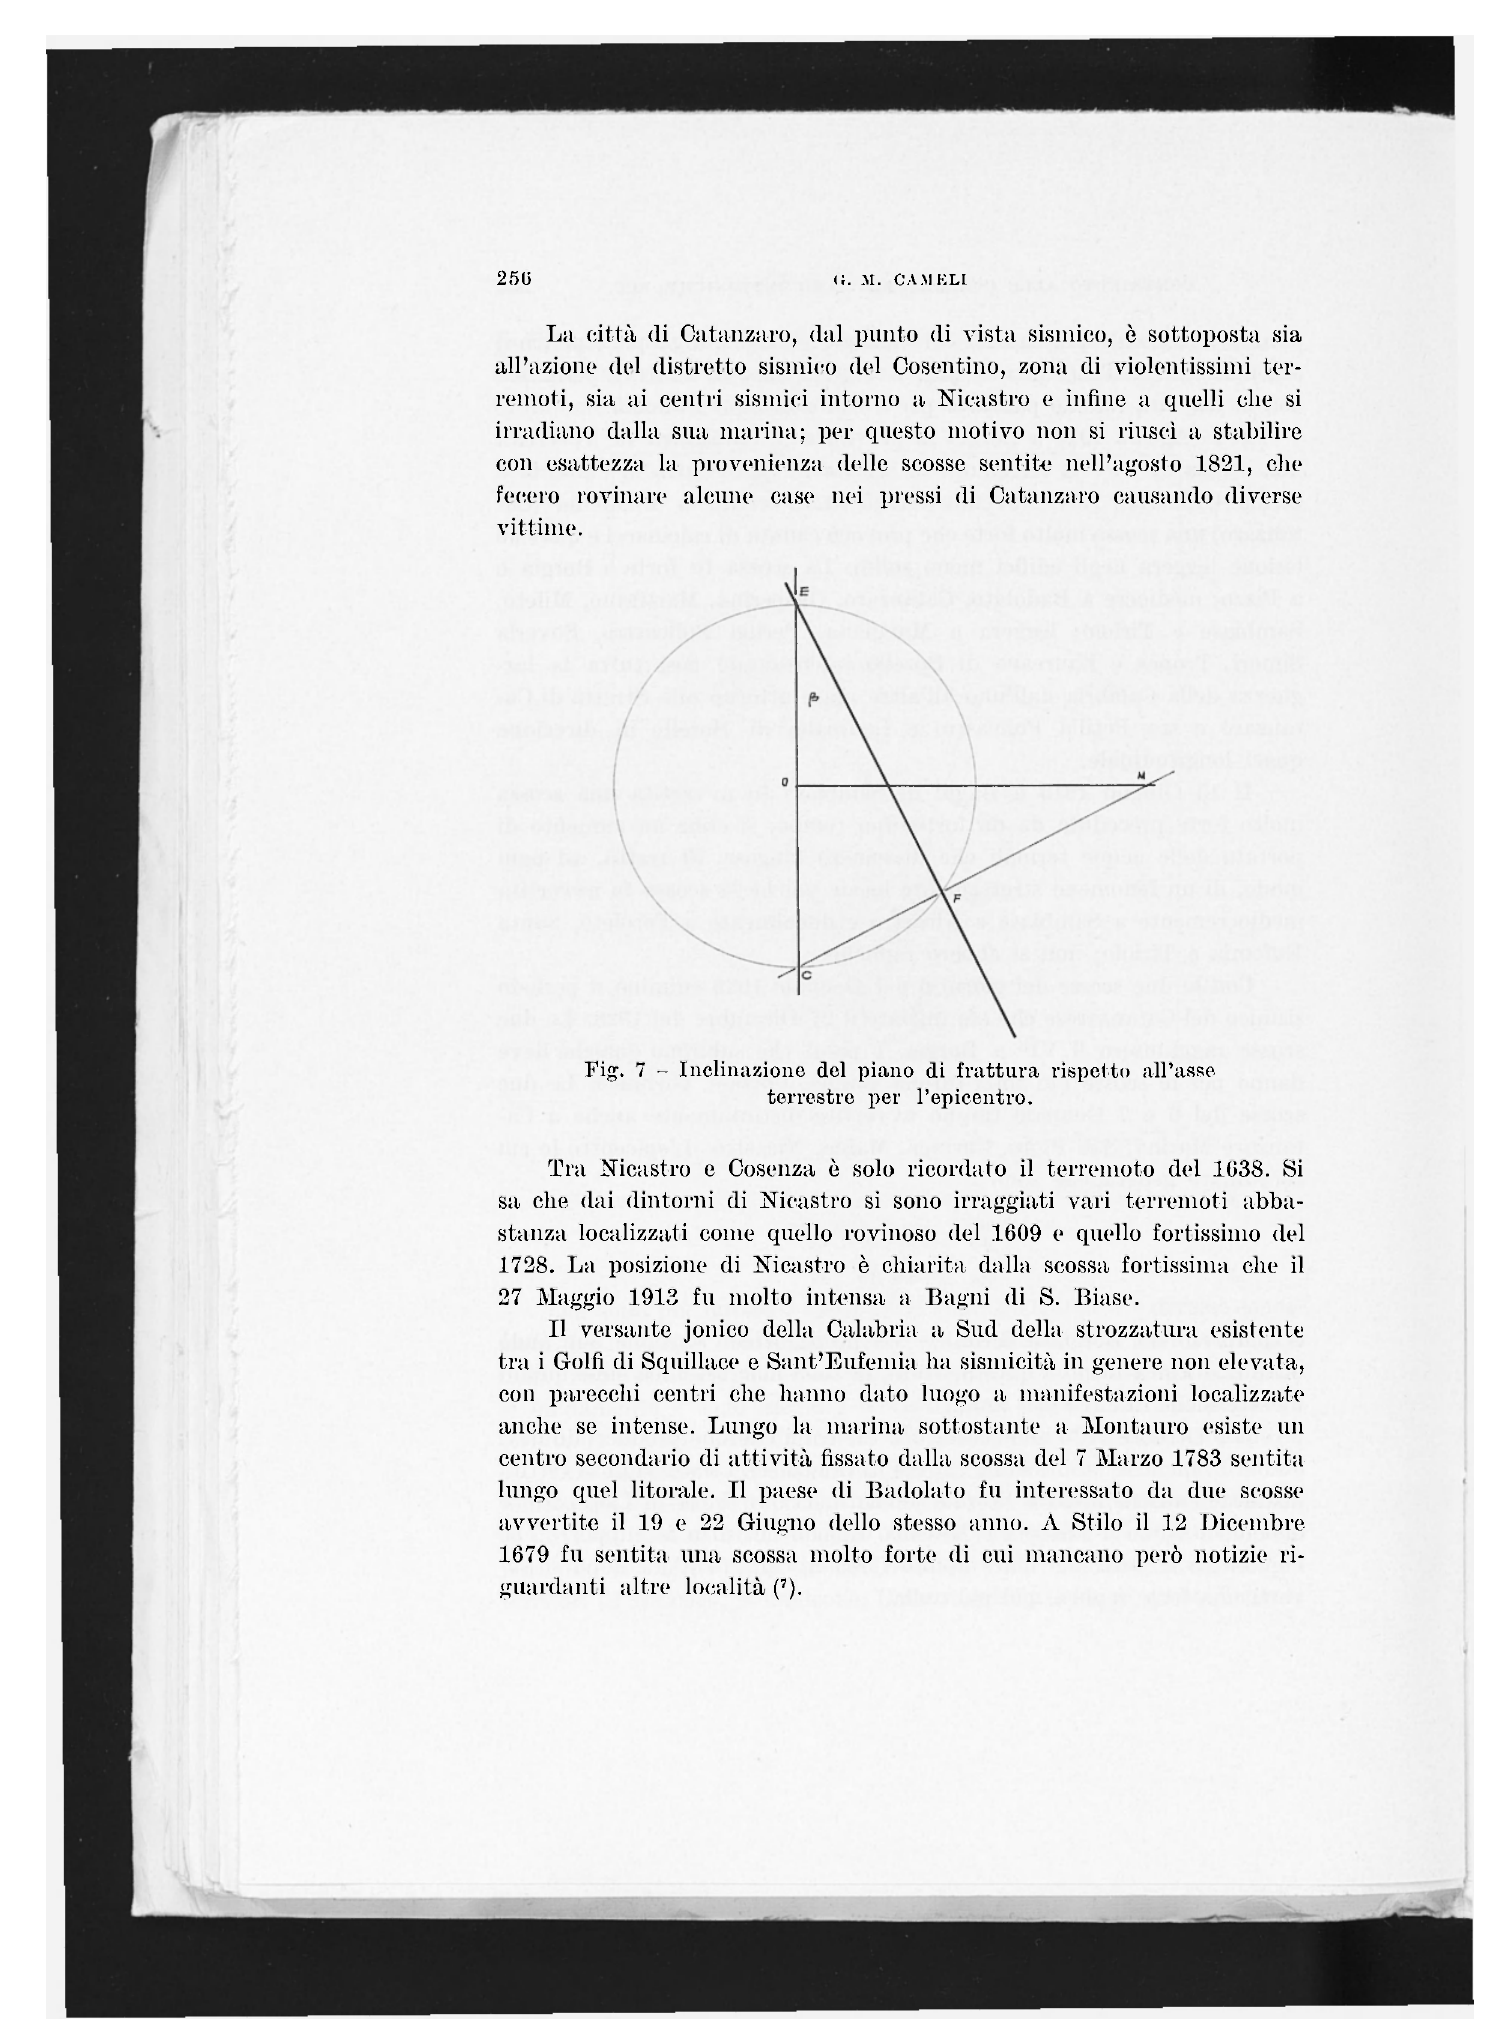
Fig. 7 - Inclinazione del piano di frattura rispetto all'asse terrestre per